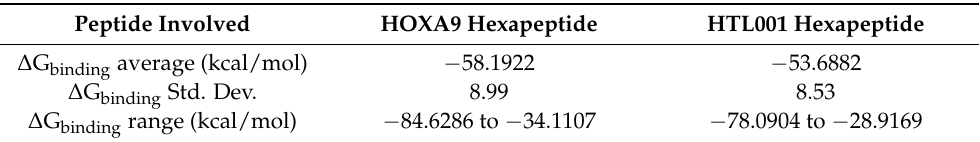
Table 2. MM-GBSA calculation results of MD simulations performed on HOXA9 and HTL001 hexapeptides in complex with PBX1 protein and DNA.